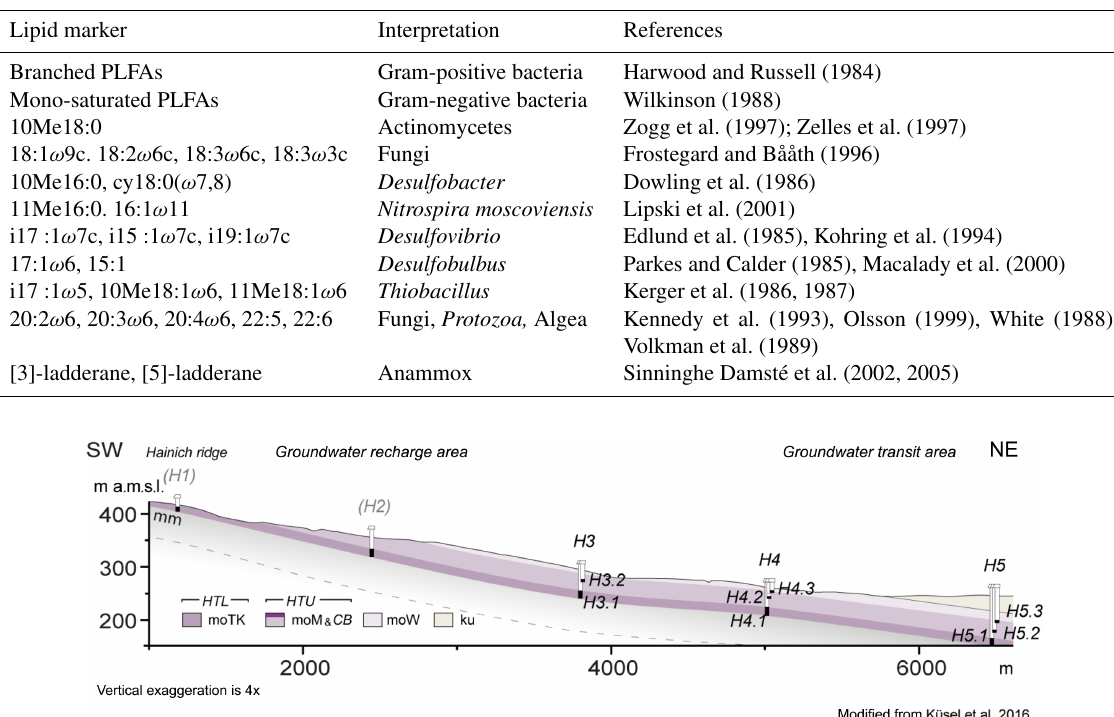
Figure 1. Schematic geological cross section of the Hainich monitoring well transect (without karst features). The wells sampled for this study are numbered in black. The black colours in the wells indicate screen sections and accessed depths of the aquifer assemblages. Abbreviations: mm: Middle Muschelkalk; mo: Upper Muschelkalk; moTK: Trochitenkalk formation; moM & CB: Meissner formation with Cycloides-Bank; moW: Warburg formation; ku: Lower